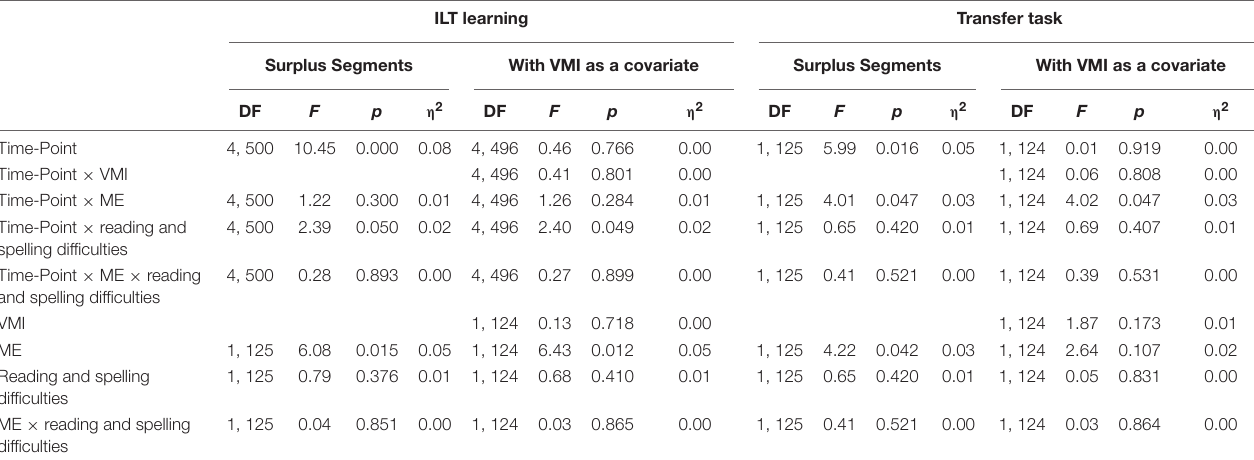
TABLE 2 | Analyses of ILT surplus